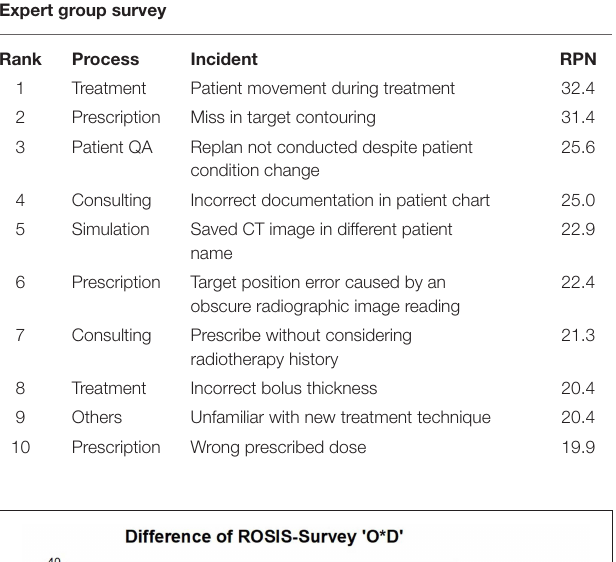
TABLE 1 | Top 10 RPN items of expert group survey. Expert group survey